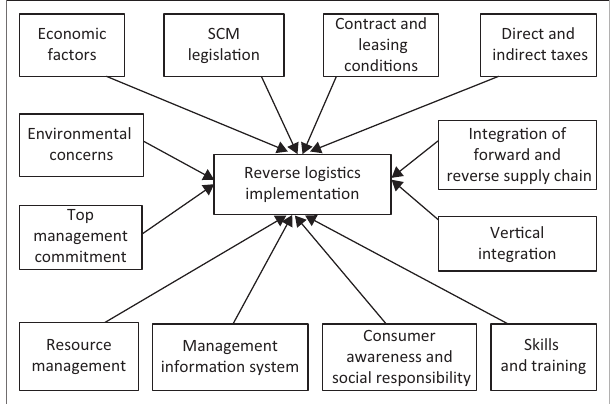
FIGURE 1: South African Police Service reverse logistics framework. FIGURE 2: Strategic